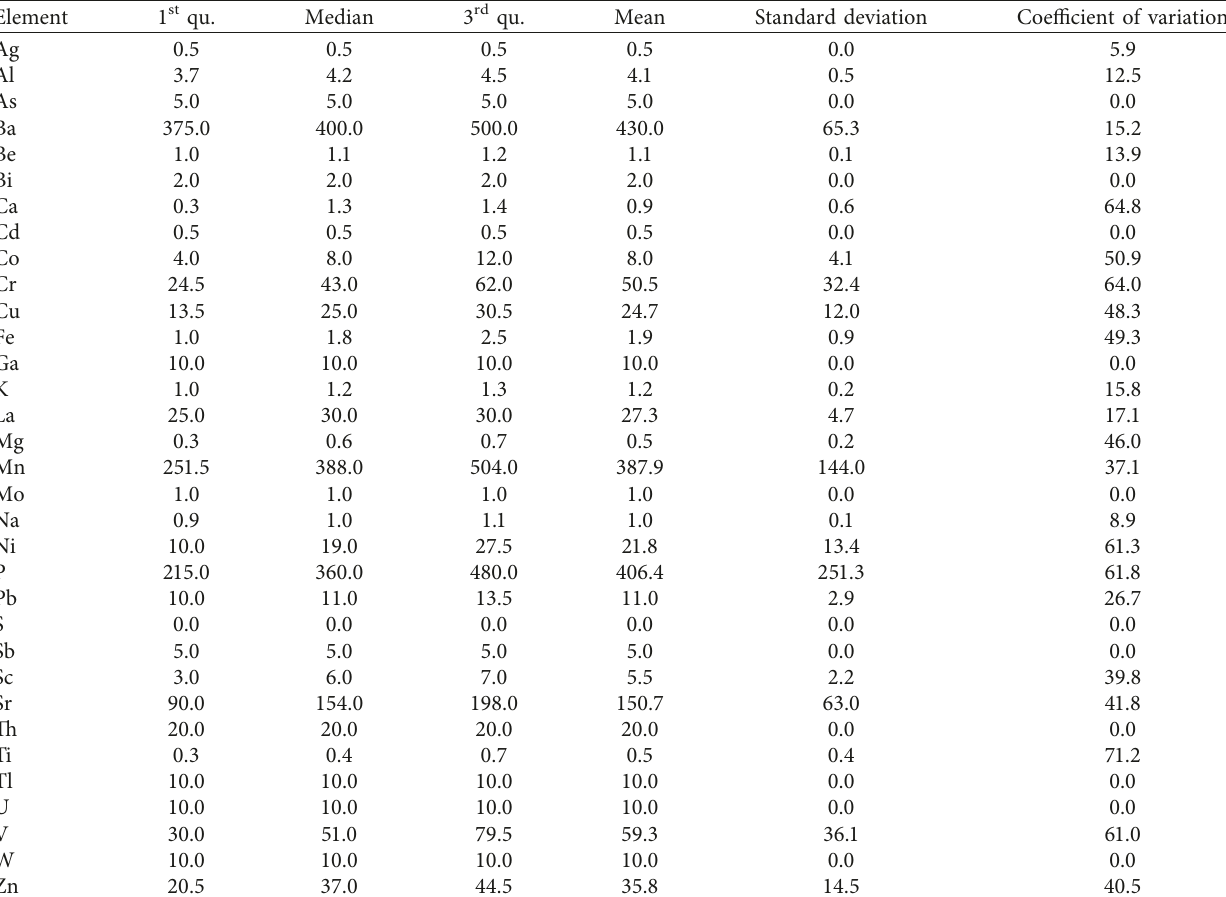
Table 1: Summary statistics for the concentration of different chemical elements within natural soils. Element 1 st